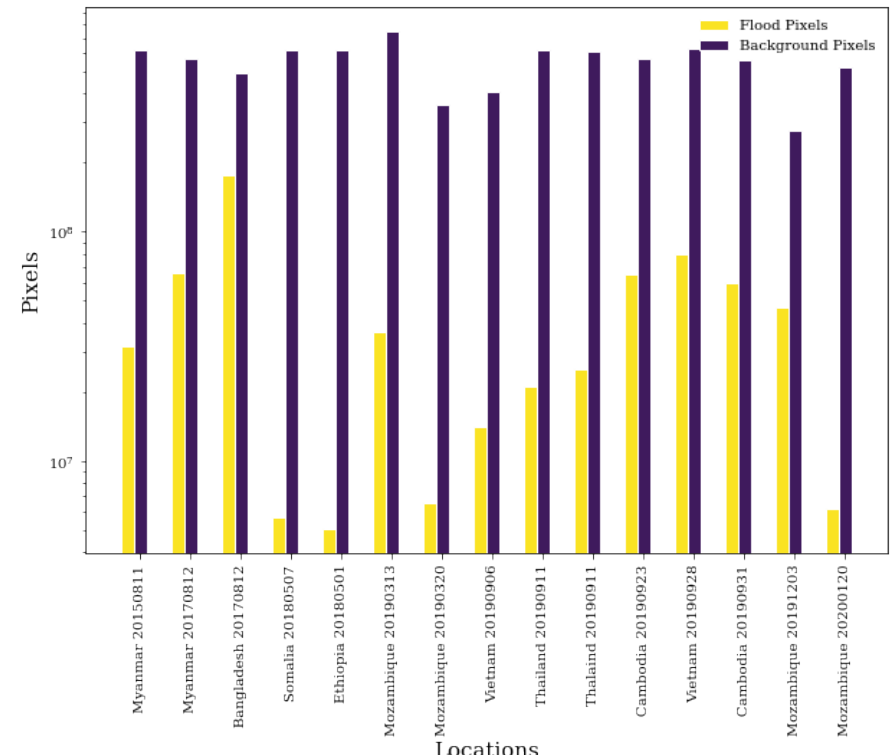
Figure 4. The number of pixels for each class in a given image. Each image is listed in the same order as used in Tables 1 and